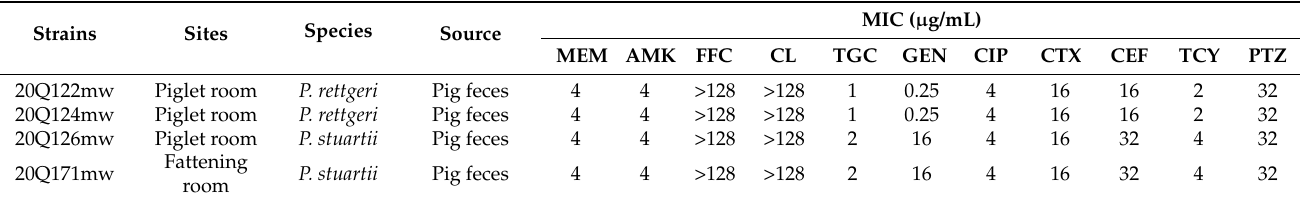
Table 1. Susceptibility of bla NDM-1 -positive Providencia strains to antimicrobial agents.